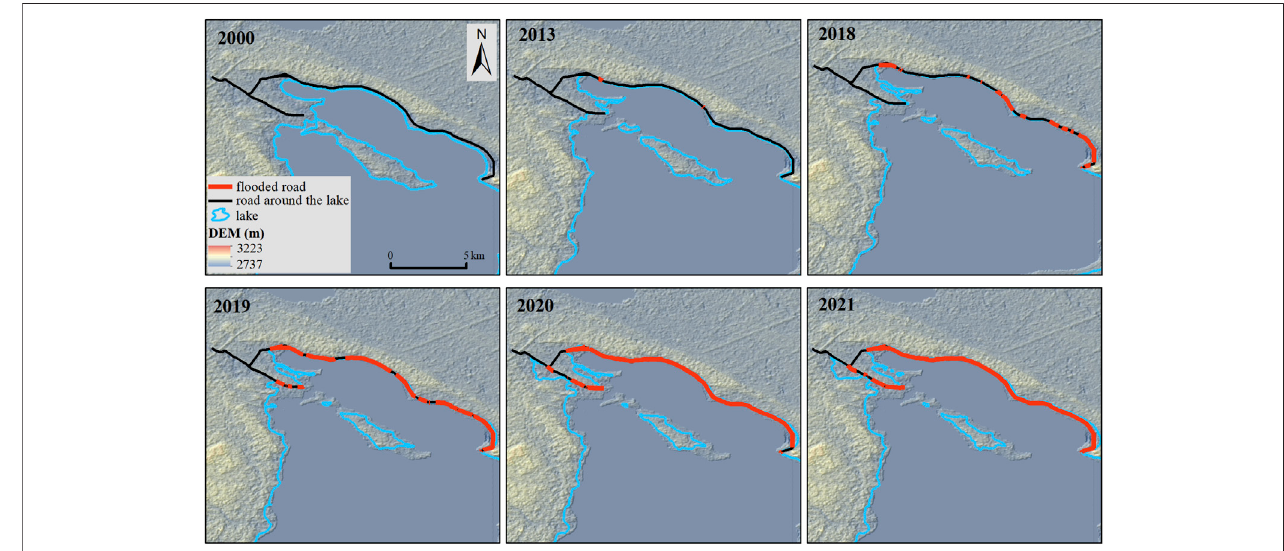
FIGURE 9 | Road inundation in 2000, 2013, 2018, 2019, 2020, and 2021.